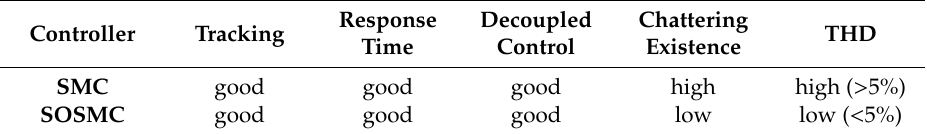
Table 4. Summary table for the comparison study.